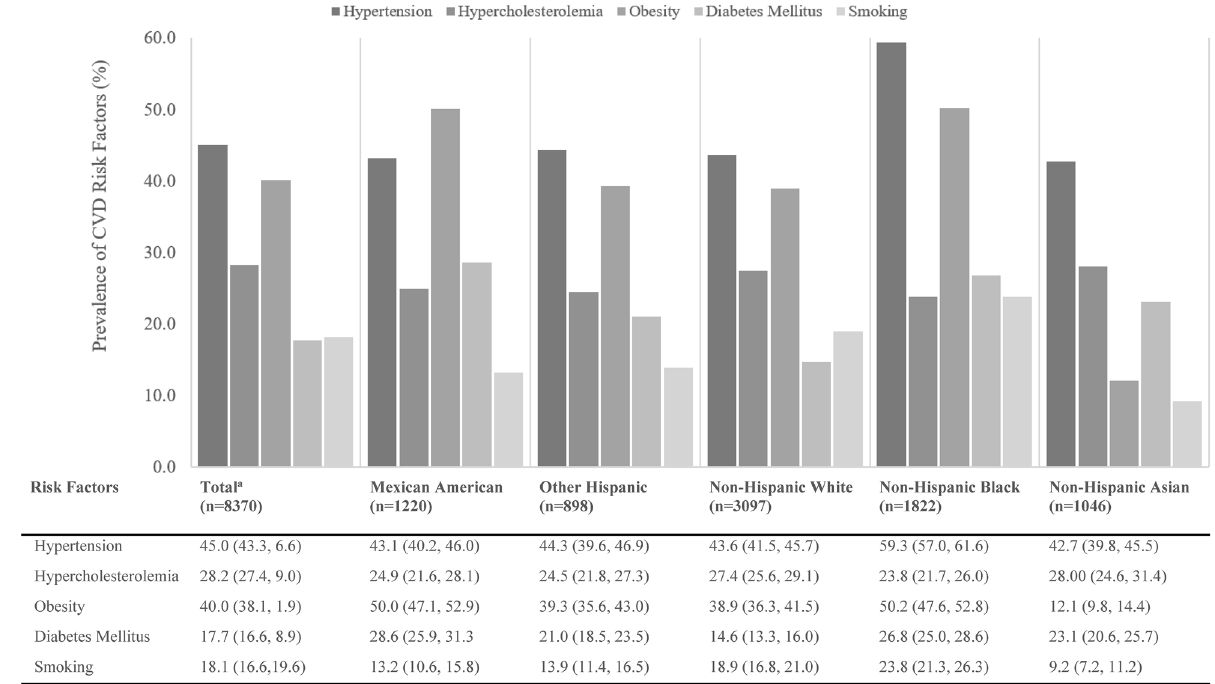
Figure 2. Age-standardized prevalence of cardiovascular disease risk factor for adults ≥ 20 years by race/ ethnicity. SBP systolic blood pressure, DBP diastolic blood pressure, BMI body mass index, FPG fasting plasma glucose, HbAlc hemoglobin Alc. Risk factors defined as, hypertension (SBP ≥ 130 mmHg, DBP ≥ 80, or taking anti-hypertensive medication), hypercholesterolemia (cholesterol ≥ 240 mg/dL, or lipid-lowering medication), obesity (BMI ≥ 30 kg/m 2 ), diabetes mellitus (FPG ≥ 126 mg/dL, HbAlc ≥ 6.5%, or taking hypoglycemic medication, smoking (smoked at least 100 cigarettes in life and currently smoking cigarettes). Statistics are displayed as percent (95% confidential interval). a All values (except n) are weighted percentages, and age standardized to Census 2010 US